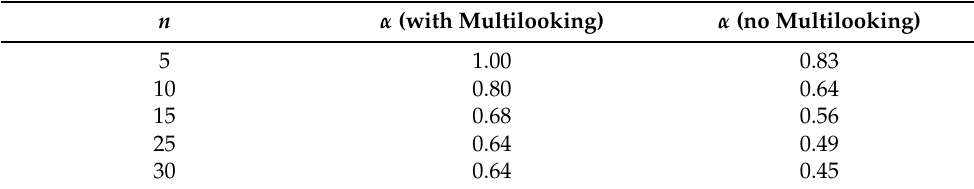
Table 1. Threshold parameter α (backscatter reduction in decibels) resulting in the best correlation between unoccupied aerial vehicle (UAV) LiDAR canopy cover loss and Sentinel-1 shadow area depending on the value of n , the number of post-disturbance images, and whether 3 × 3 spatial multilooking was